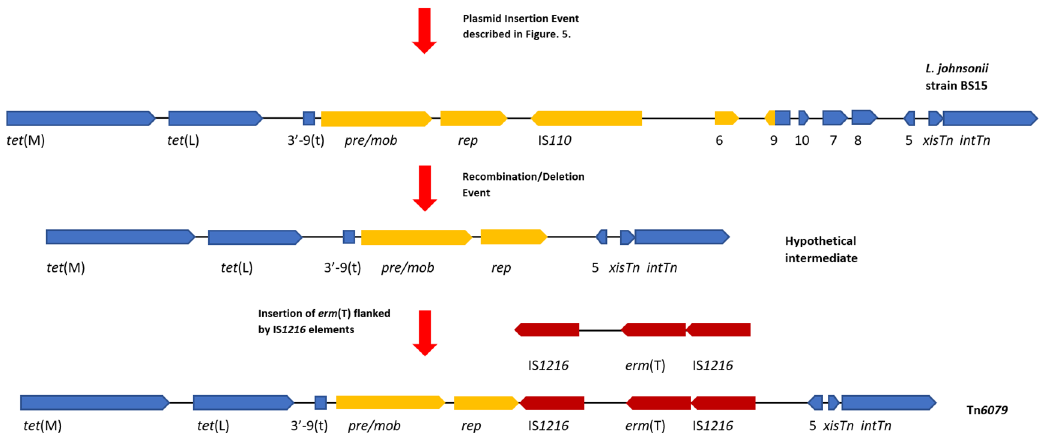
Figure 5. A diagram of the hypothetical events that created Tn 6079 . This hypothetical event assumes that the left 7226 bp of TT31 are part of a larger Tn 916 -like element. Gene diagrams are not to scale. Following on from the insertion event that created the L. johnsonii strain BS15 ‘intermediate’ Tn 916 -like element described in Figure 4, a deletion / recombination event results in the loss of orf6 , orf9 , orf10 , orf7 and orf8 , forming a hypothetical intermediate CTn. Insertion of erm (T) flanked by IS 1216 elements (dark red) follows this deletion event creating Tn 6079 . For continuity with Figure 4, tet (M), tet (L), orf5 , xisTn and intTn and the 3 ′ —end of orf9 (t) are coloured blue and the plasmid associated genes are yellow.